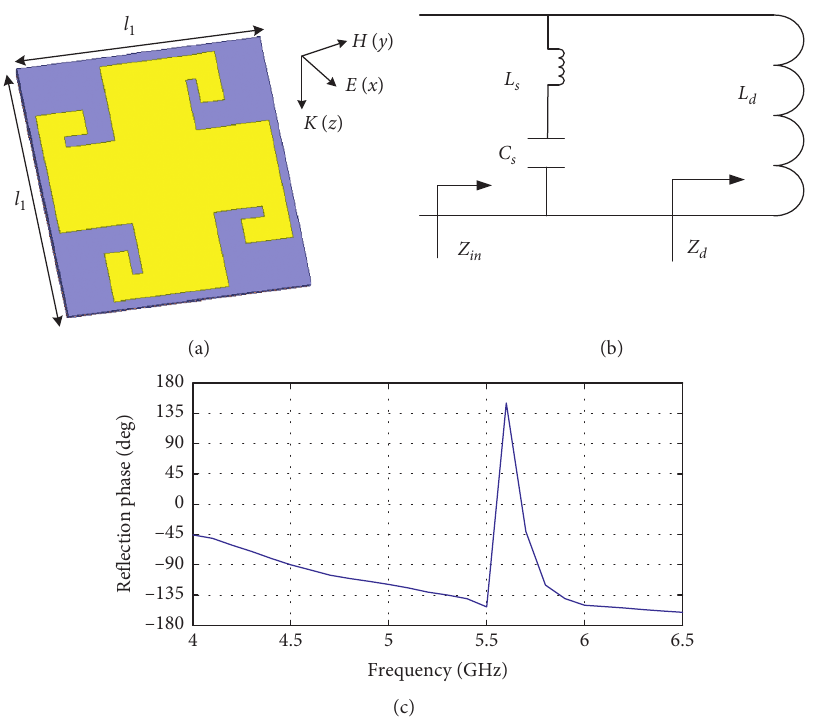
Figure 2: (a) Wan-type metasurface unit structure; (b) equivalent circuit; and (c) reflection phase of bending of the integrated MSs antenna is barely impactful on Figure 11 represents the antenna E- and H-plane gain total the radiation. It is indicated that the proposed antenna indeed radiation pattern at 5.2GHz and 5.8GHz in differing cir- has a little influence on the property caused by bending. cumstances of bending, respectively. The figure reveals that the